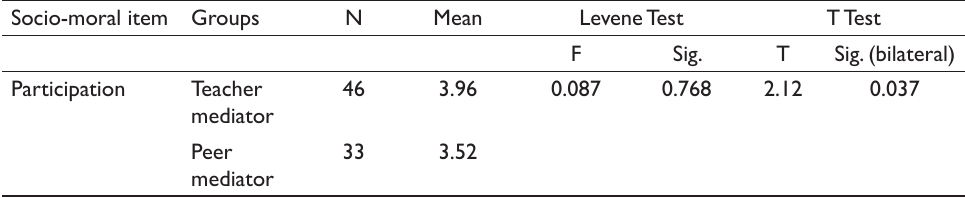
Table 7: Significant differences in the socio-moral items between teacher mediator and mediated student